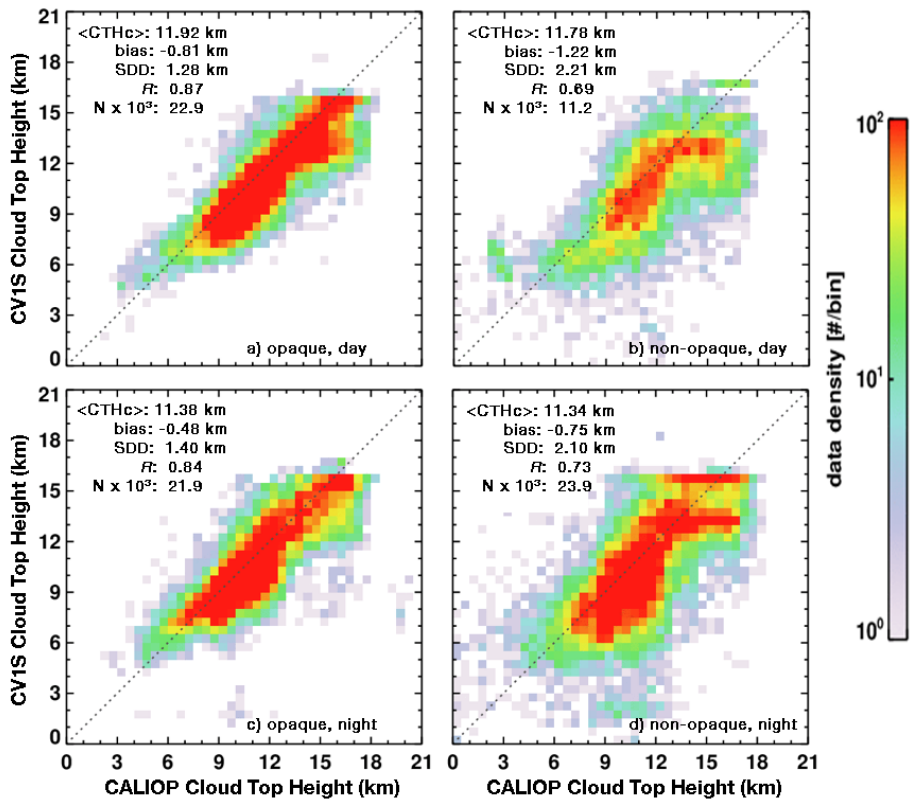
Figure 8. CV1S versus CALIOP cloud-top heights for all 0/100 single-layer ice clouds, JAJO 2015–2016, ( a , b ): Daytime, ( c , d ): Nighttime. ( a , c ): opaque, ( b , d ): non-opaque. Table 5 lists the mean differences and associated statistics for non-opaque ice clouds.